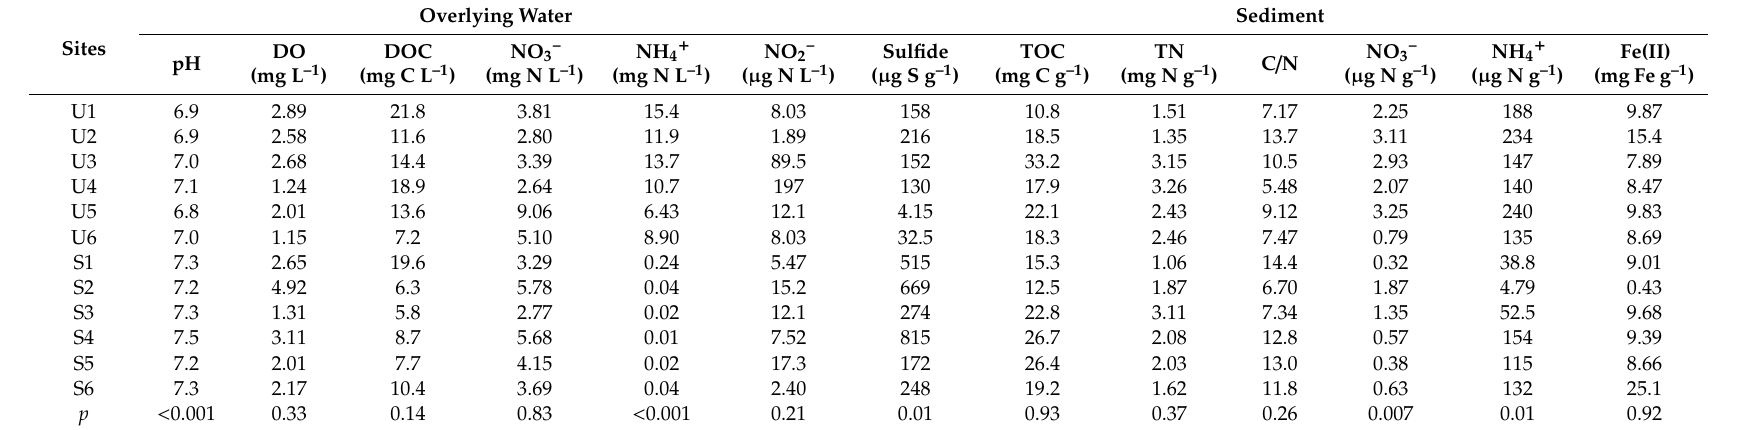
Table 1. Chemical properties of overlying water and sediments in the urban and suburban rivers.